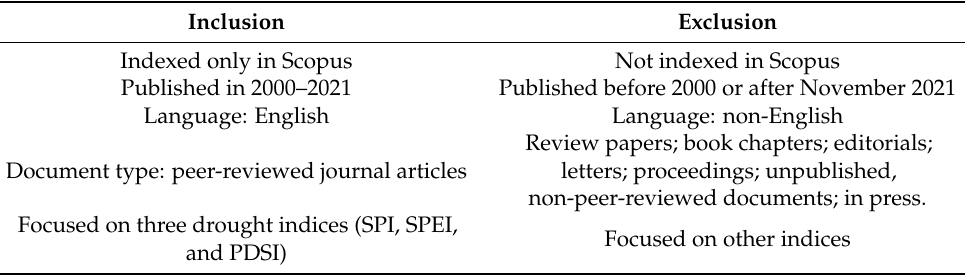
Figure 1. Systematic Reviews and Meta-Analyses diagram. Table 1. Inclusion and exclusion criteria.